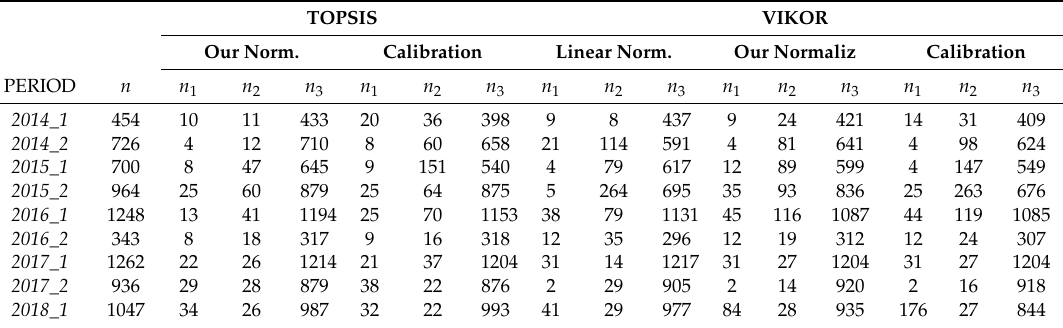
Table 6. Values of n 1 , n 2 , and n 3 in the cases